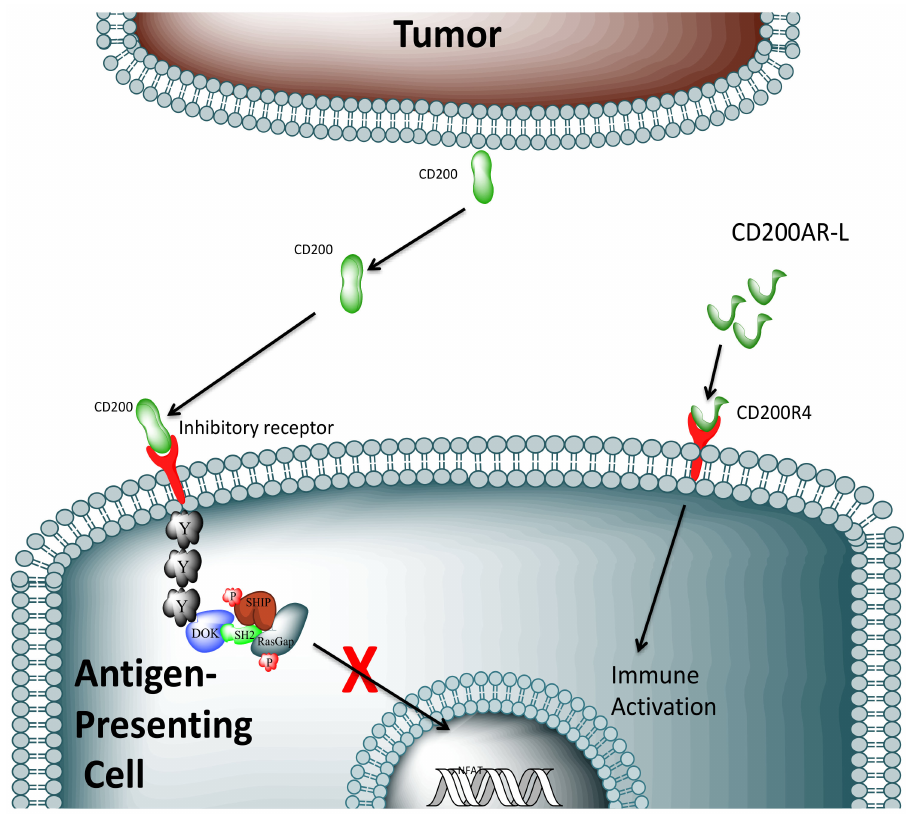
Figure 1. Experimental model. Full-length CD200 secreted from tumor cells binds to the CD200 inhibitory receptor (CD200R1) on antigen-presenting cells, shutting down an immune response. In addition to the inhibitory receptor, the CD200 checkpoint has CD200-like activation receptors (CD200R4) that have adjuvant-like properties when stimulated; ligation with the CD200 activation receptor peptide ligand (CD200AR-L) activates an as yet undetermined signaling cascade that surmounts the inhibitory signals and allows activation of and normal antigen presentation by the antigen presenting cell. Permission by Michael R. Olin, University of Minnesota, Minneapolis, MN. Unpublished work,